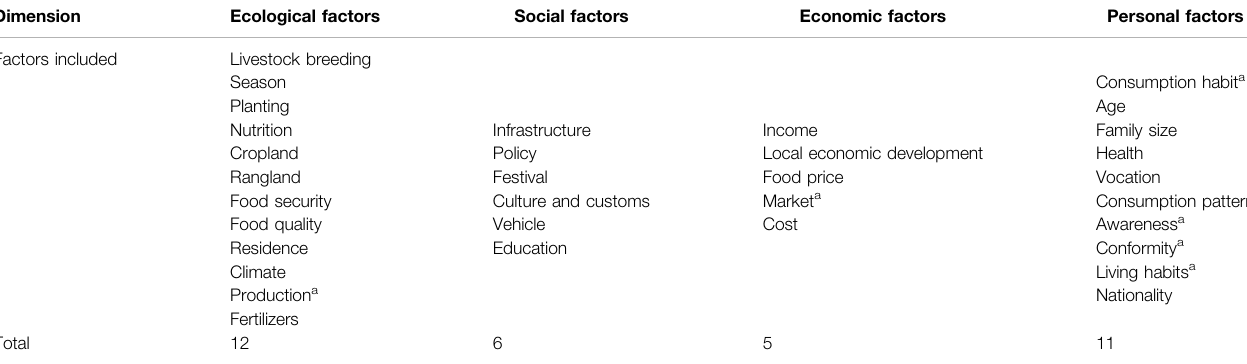
TABLE 2 | Food consumption impact factors and their classi fi cation under four dimensions. Data source: All factors derive from our 2019 fi eld survey. Dimension